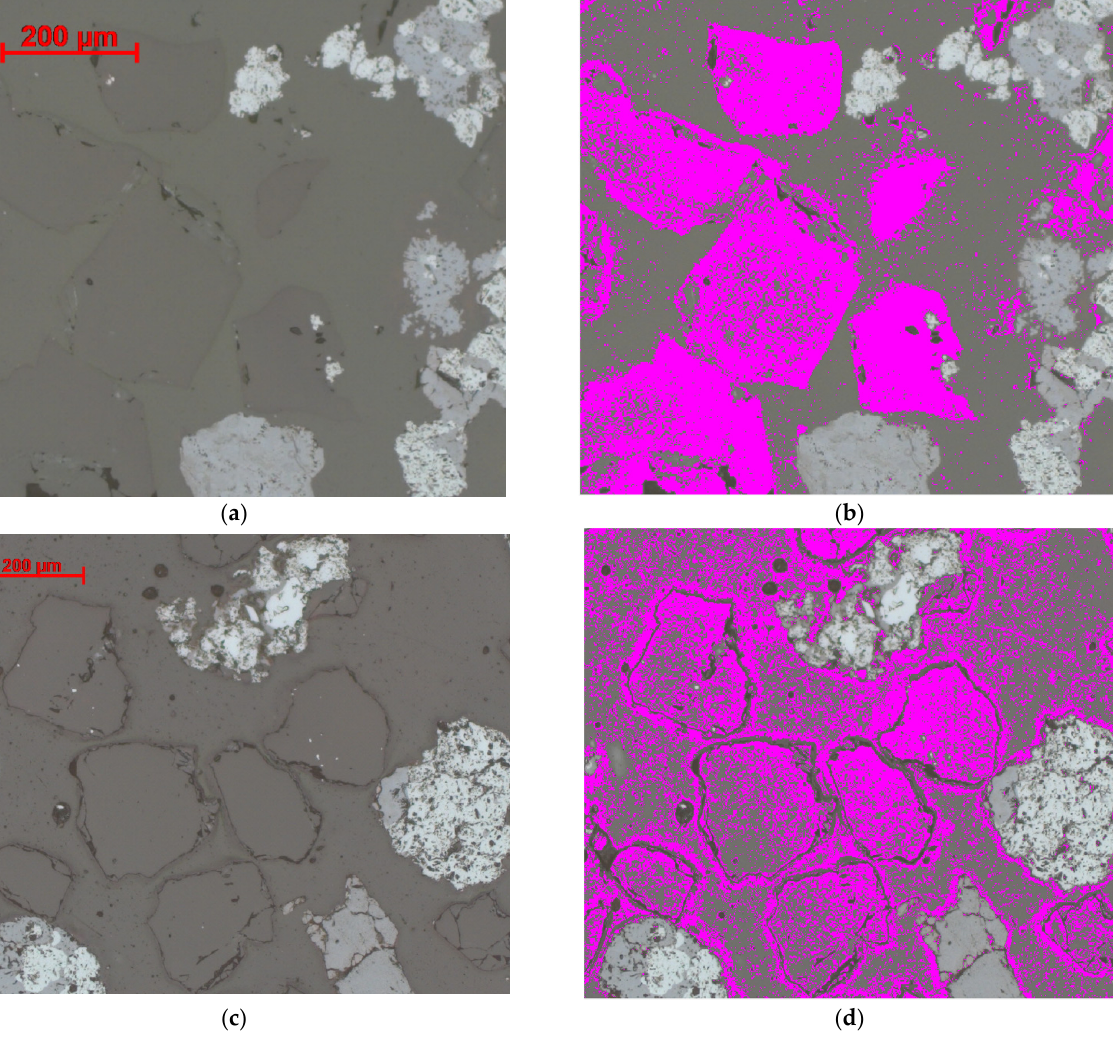
Figure 1. Iron ore images from two epoxy blocks from the same sample, with ( a ) and without ( c ) Epodye, taken at magnification ×200, and optimal segmentation of quartz by thresholding, ( b ) and ( d ) correspondingly.